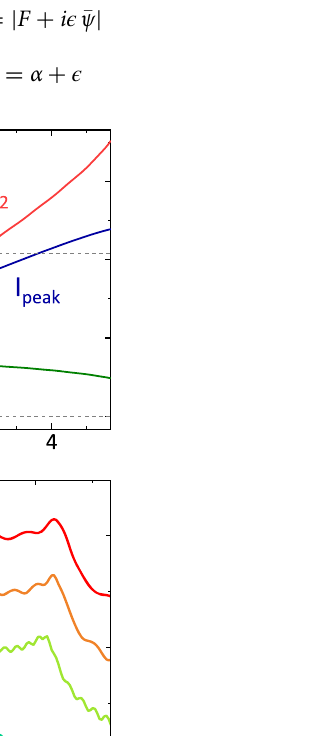
α ⋯ < α 1 < 2 6 ), showing the increase